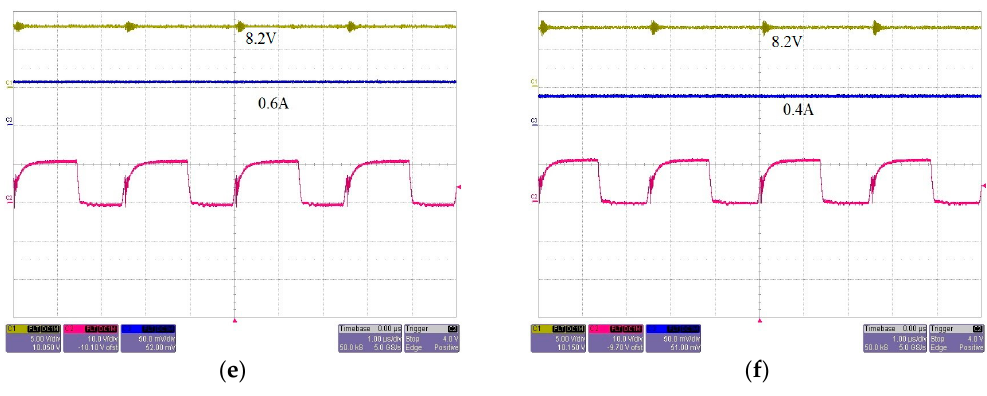
Figure 9. Experimental results of multistage pulse charging of a two cell battery pack (top to bottom: battery voltage, charging current, and gating signal of switch). ( a ) Initial charging; ( b ) stage 1; ( c ) stage 2; ( d ) stage 3; ( e ) stage 4; and ( f ) stage 5.